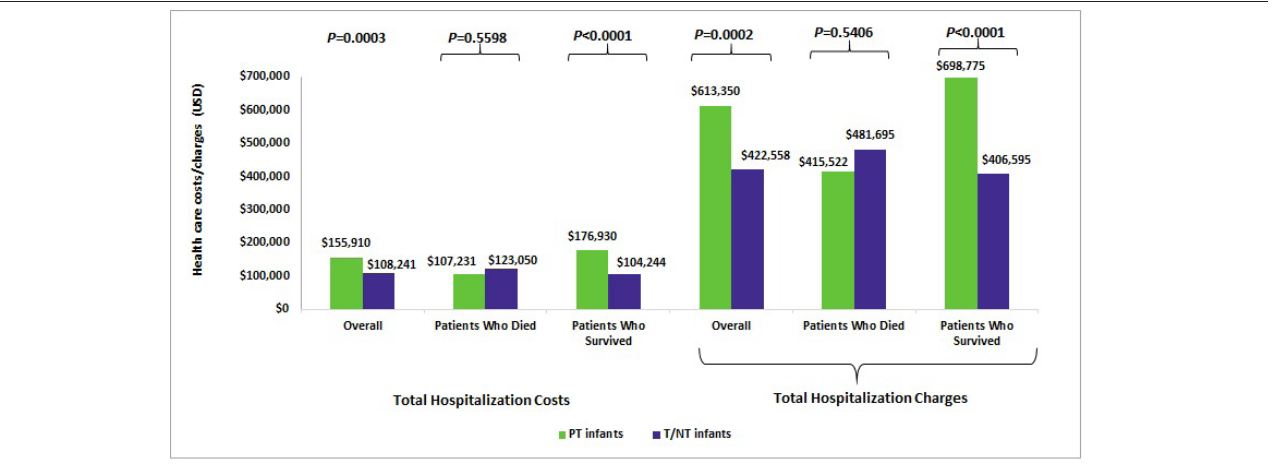
Figure 2. Economic Outcomes Among Preterm and Term/Near-term Infants diagnosed with HRF/